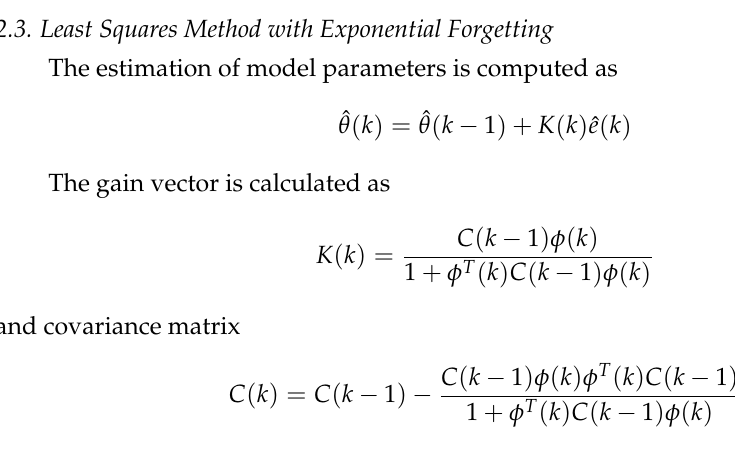
Figure 2. Identification scheme for continuous-time systems.